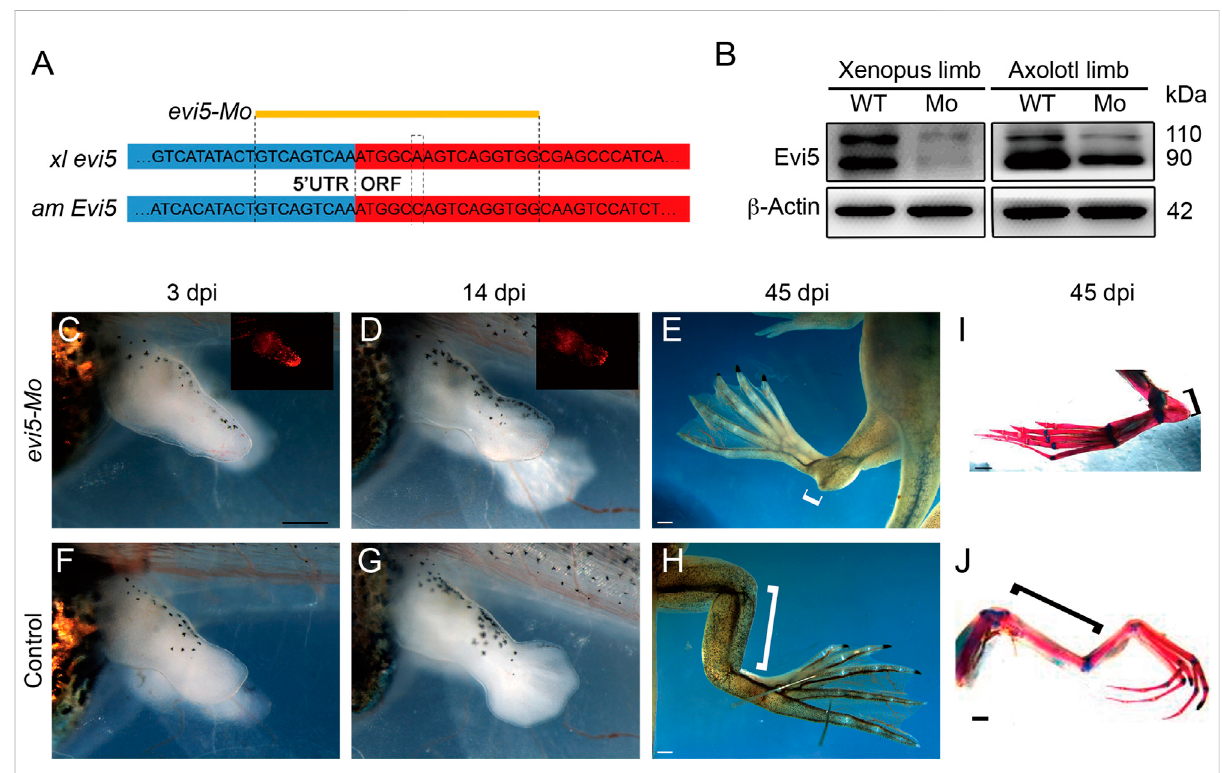
FIGURE 2 Effectof evi5 Moonlimbdevelopmentof Xenopus . (A) Designof evi5 Moagainst Xenopusevi5 ( xlevi5 )andaxolotl Evi5 ( amEvi5 ).Openreading frame indicated in red, targeted region of evi5 Mo shown in yellow. (B) Detection of Evi5 protein by Western blotting, in Xenopus and axolotl limb stump after injection and electroporation of evi5 Mo. Anti-Evi5 (ab 70790) was used for Evi5 protein. β -Actin used as loading control. (C – H) KnockdownofEvi5expressionduringlimbdevelopment.TheMo-injectedlimbs (C – E) showedsigni fi cantdevelopmentaldelaycomparedwith the control group (F – H) , and developmental abnormalities were observed at late developmental stages (white brackets indicate the length of the zeugopods). (I,J) Skeletalstainingofhindlimbsatlatedevelopmentalstages,withredindicatingbonetissueandblueindicatingcartilagetissue.Black brackets indicate zeugopods. Scale bars represent 500 μ m in (C,D,F,G) and 1 mm in (E,H) and (I,J)